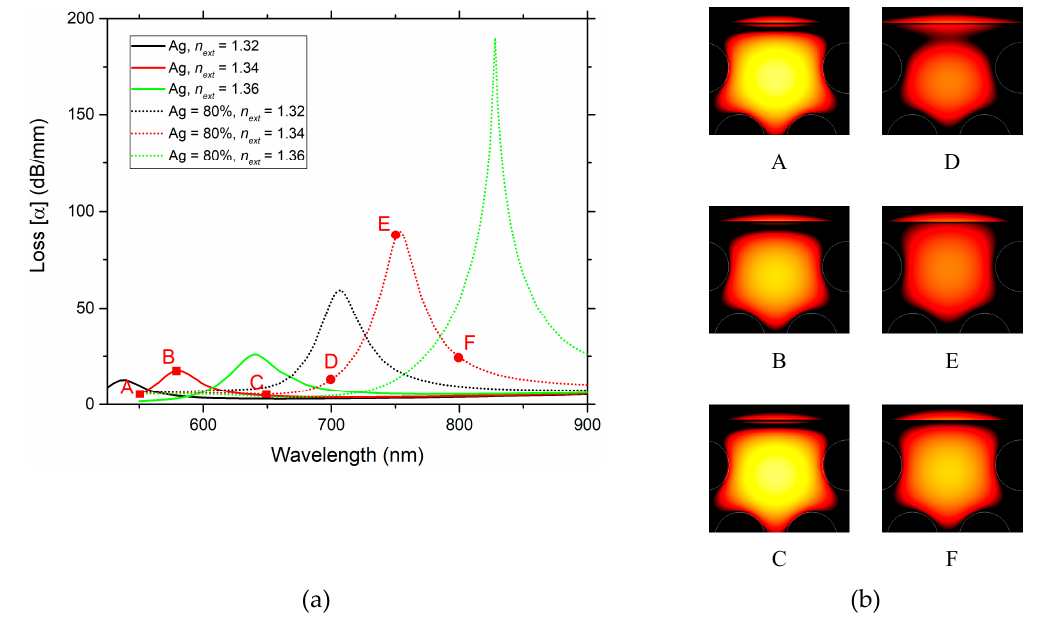
Figure 9. ( a ) Loss as function of wavelength for two different layers, one with only Ag and the other with the metamaterial considered (80% Ag and 20% Al 2 O 3 ), when subjected to different n ext values. ( b ) Light distribution in the core fiber region and in the region of the metal/metamaterial film for n ex t = 1.34 and for two concentrations of Ag (100% and 80%). The pure silver film is in the left column and the metamaterial film is in the right column.